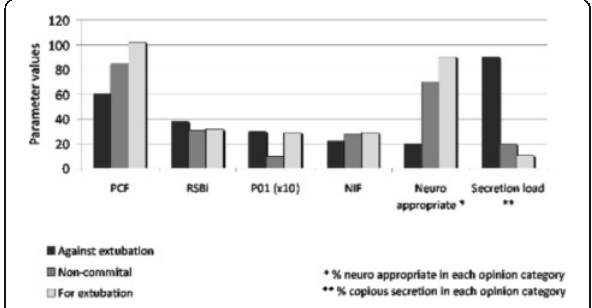
Fig. 100 (abstract A228). Parameters in relation to PT advice